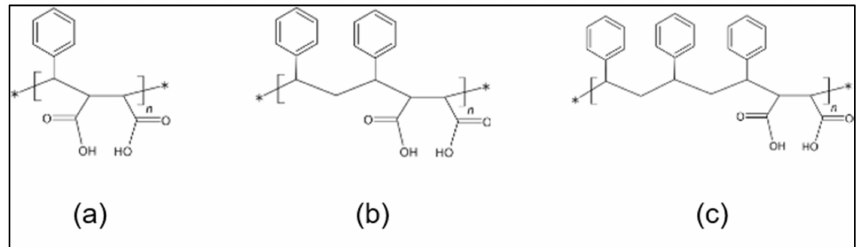
Figure 4. Structures of three types of SMA copolymer dispersants synthesized in this study; SMA-1000 ( a ), SMA-2000 ( b ), and SMA-3000 ( c